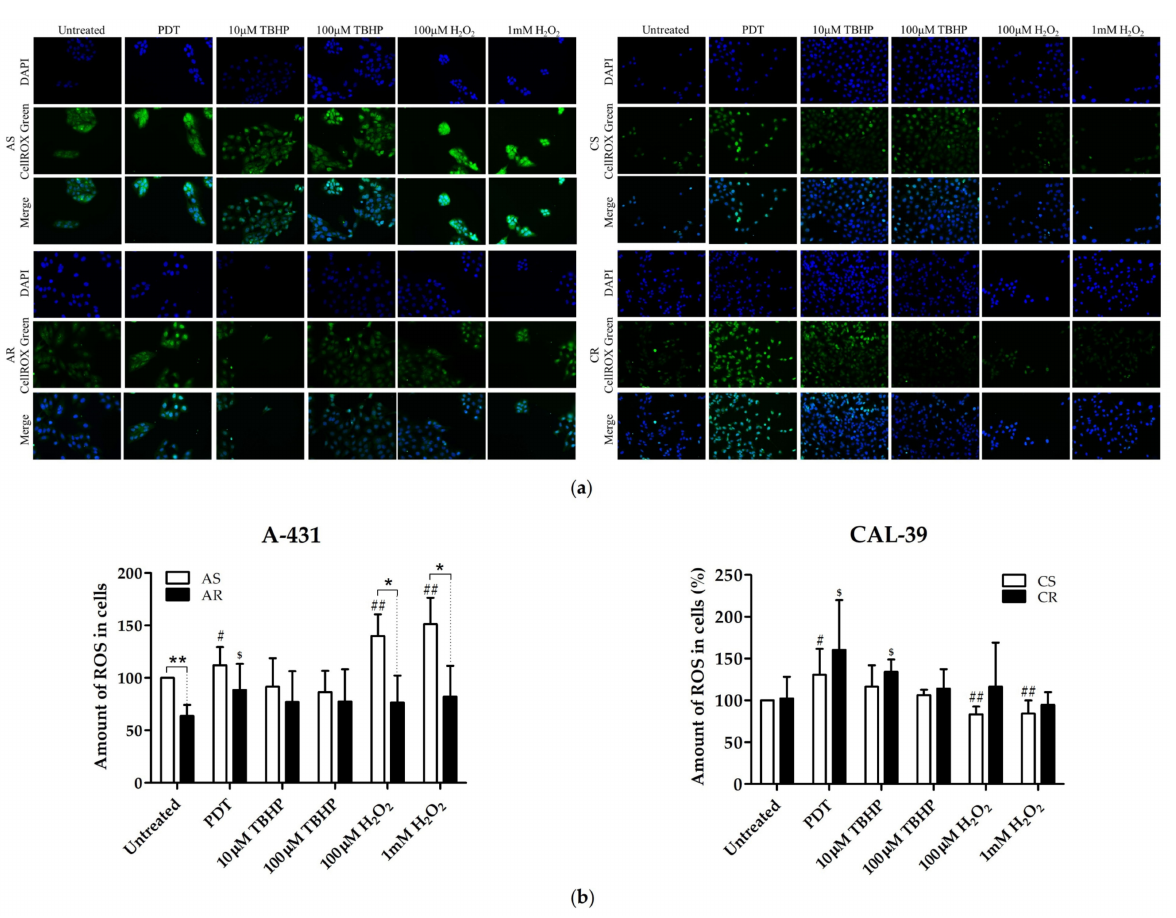
Figure 4. Assessment of oxidative stress. ( a ) Images of stained cells before and after treatment. Pictures were taken by the use of Olympus ScanR fluorescence microscope with 20 ×